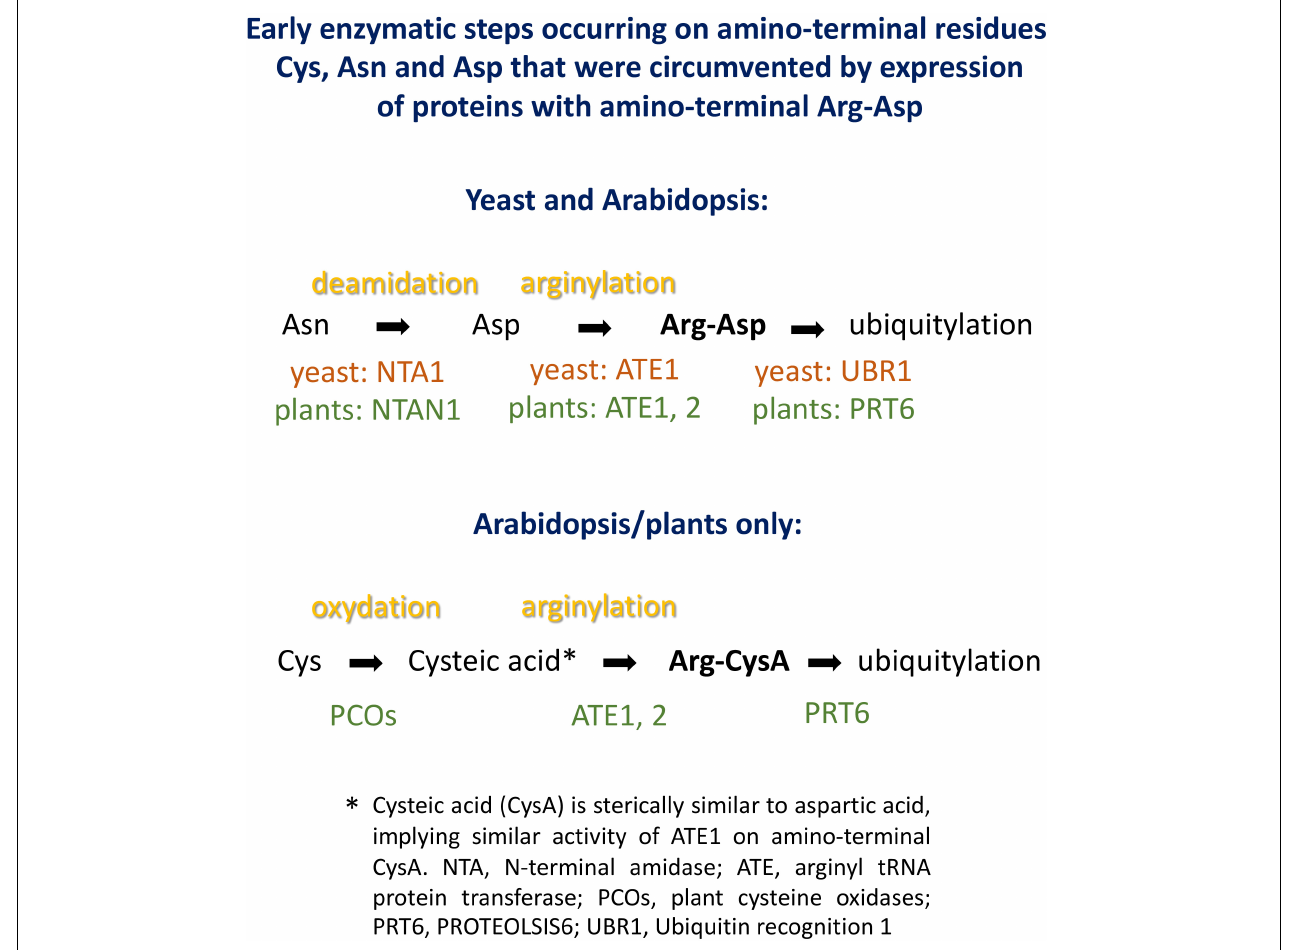
FIGURE 3 | Potential processing steps occurring on amino-terminal Asn, Asp and Cys to generate substrates for N-recognins PRT6 and UBR1.